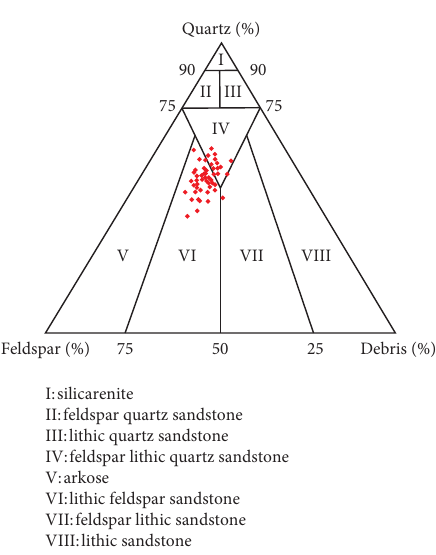
Figure 2: Ternary diagram of mineralogy in Chang 2 sandstone.